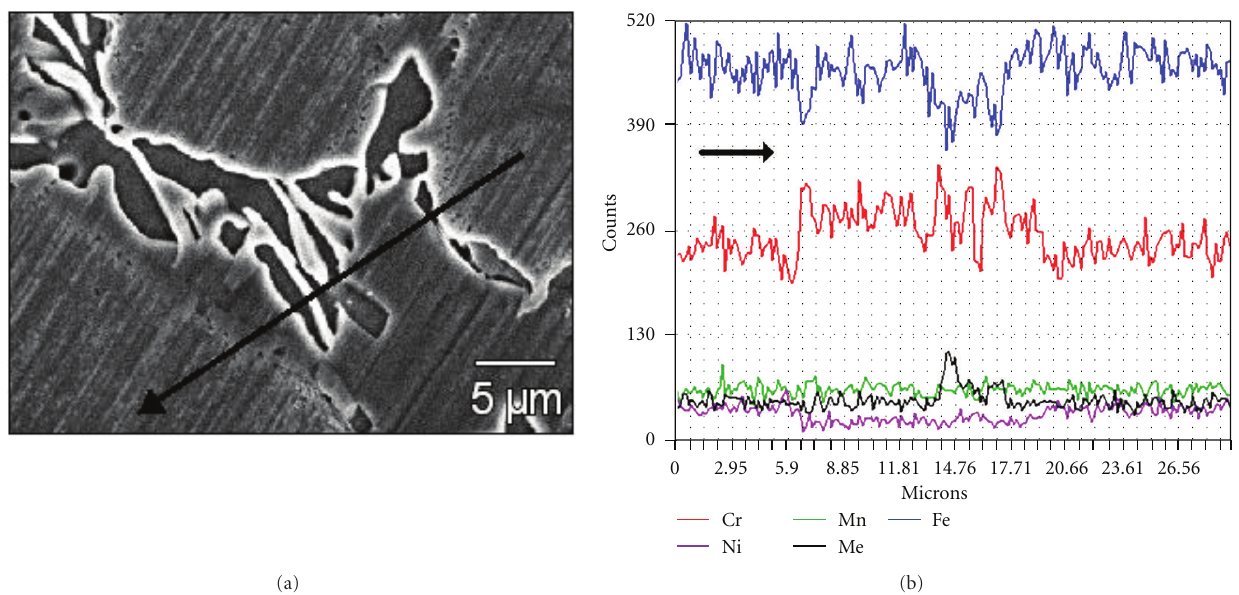
Figure 6: SEM image and profile line analysis of Cr, Ni, Mo, Mn, and Fe for the sample aged at 800 ◦ C for 316 min showing chromium depleted areas due to the precipitation of σ -phase.